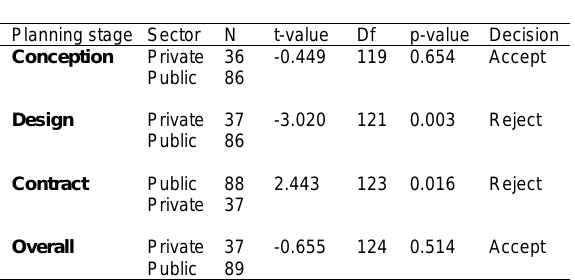
Table 3: Results of t-test for differences in the